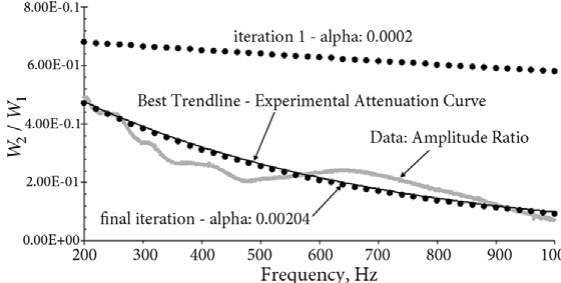
fig. 10. The decay curve of the amplitude ratio (attenuation curve) versus frequency at 100 cm receiver spacing table 2. The averaged dynamic properties of pavement subgrade layers obtained from SASW measurement Attenuation Damping ratio V S , m/s E , MPa range 10 -3 , 1/m range, % average average 101